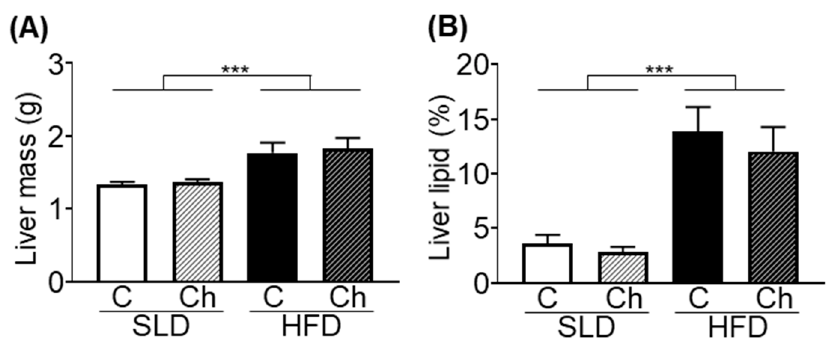
Figure 2. High fat diet (HFD) feeding but not chronic isoleucine treatment increased the liver mass and lipid content in mice. ( A ) Liver mass and ( B ) percentage lipid area per 1 mm 2 liver area of standard laboratory diet (SLD) and HFD-mice (SLD / HFD-Control (C) and SLD / HFD-Chronic (Ch), n = 8–10). Values are mean ± SEM. *** p < 0.001; diet effect, two-way ANOVA.